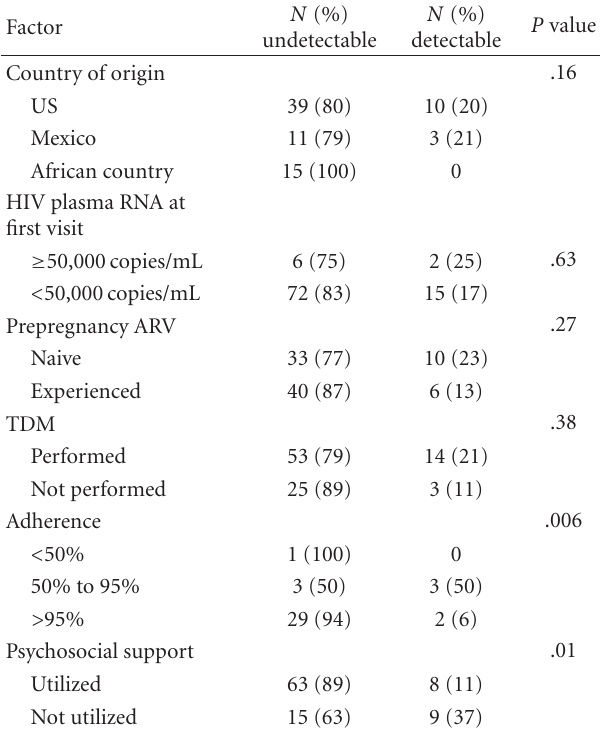
Table 4: Relationship between virologic response to ARV during pregnancy and selective factors that may a ff ect this